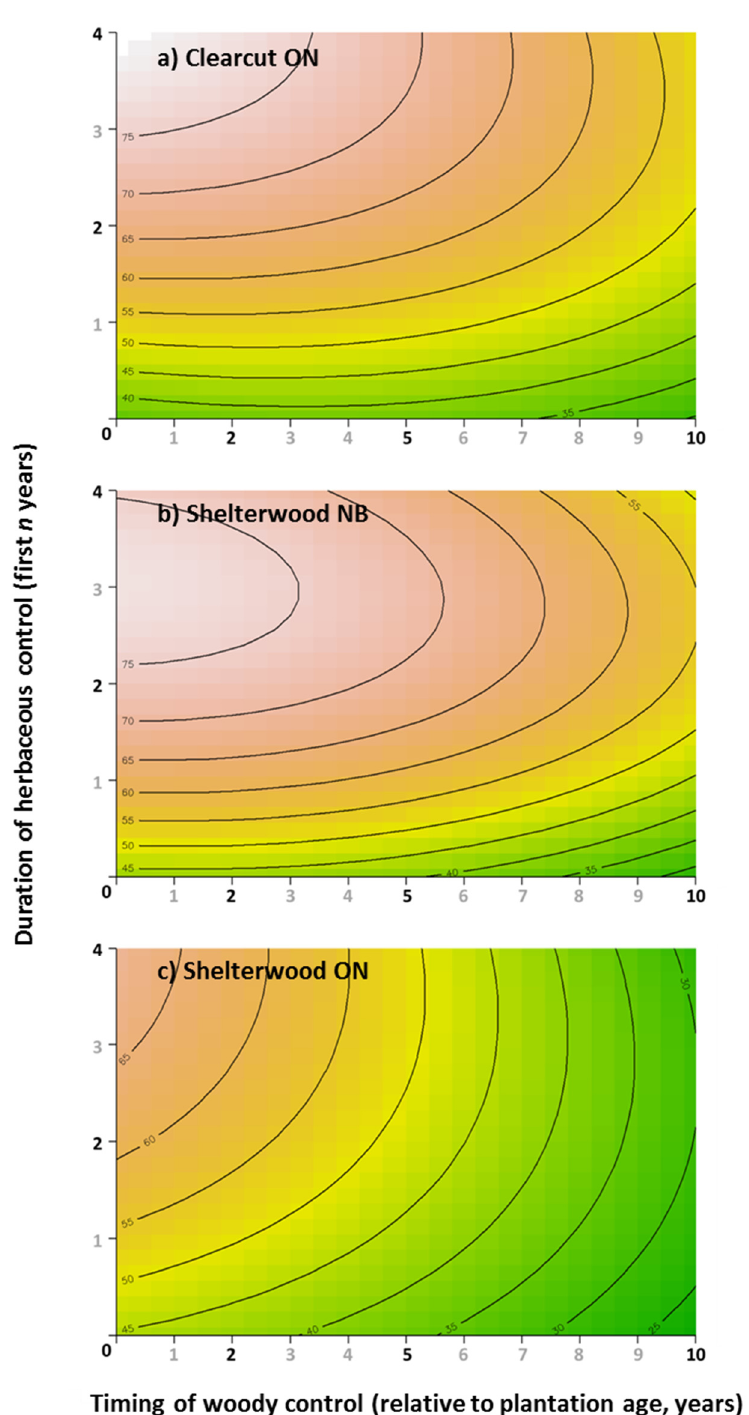
Figure 2. Two-dimensional representations (contour plots) of the response surfaces for age-10 planted pine stem diameter (mm) for the clearcut ( a ) and shelterwood NB ( b ) and ON ( c ) sites ( n = 60 observations for each). Colour tones move from largest (white) to smallest (green) diameters. See Table 2 for model statistics.